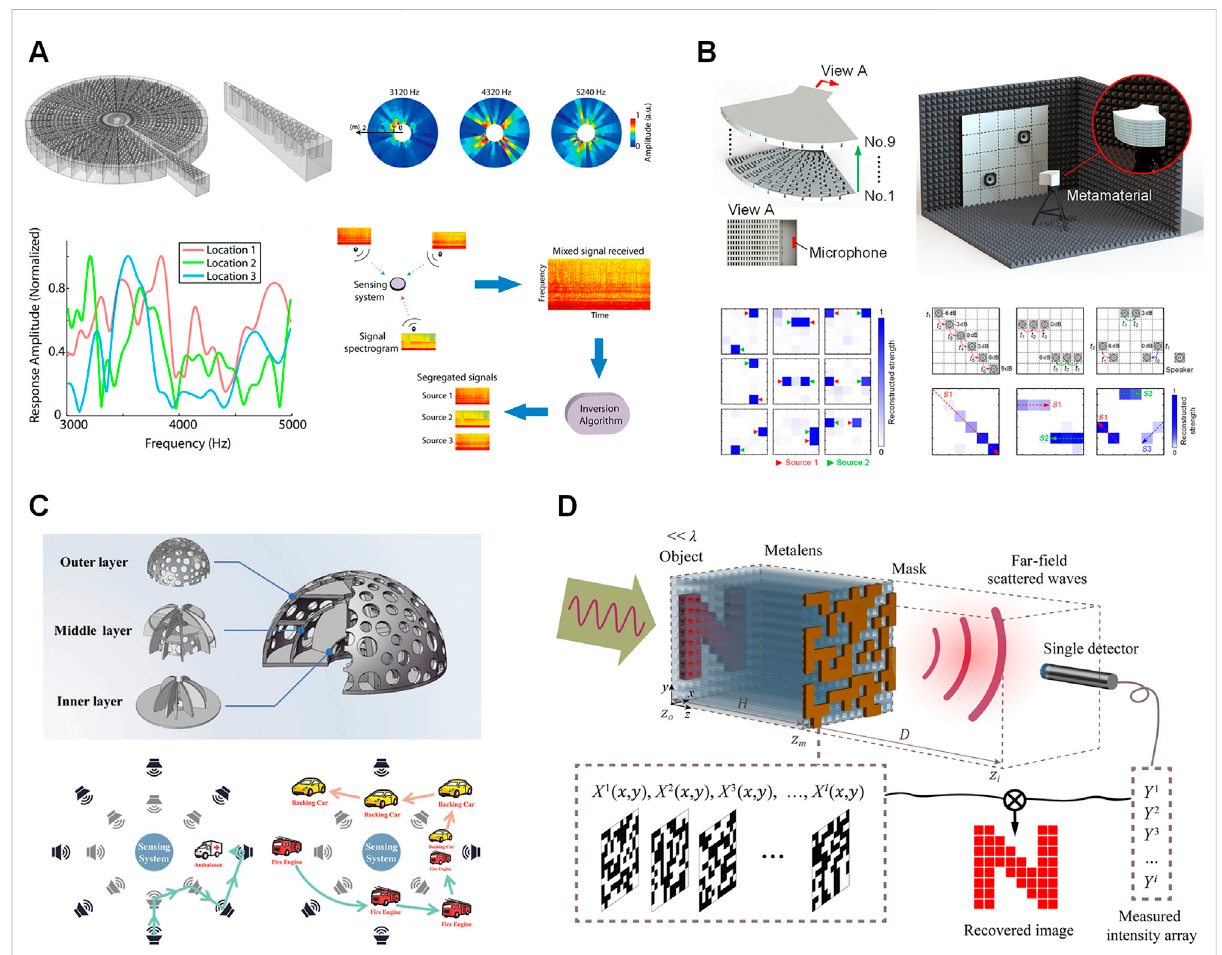
FIGURE 7 Single-sensor computational sensing with metamaterials for audio acoustic waves. (A) Single-sensor multiple speaker listening system with acoustic metamaterials [68]. (B) A prototype of single-detector acoustic camera realized by space-coiling anisotropic metamaterials [69]. (C) A metamaterial enclosure for 3D space sound localization and separation [120]. (D) Far- fi eld subwavelength acoustic computational imaging with a singledetector[11].Figurereproducedwithpermissionfrom: (A) ,©2015,NationalAcademyofScience; (B) ,©2019,AmericanPhysicalSociety; (C) , © 2019, The Authors. Published by WILEY-VCH Verlag GmbH & Co. KGaA, Weinheim; (D) , © 2022, American Physical